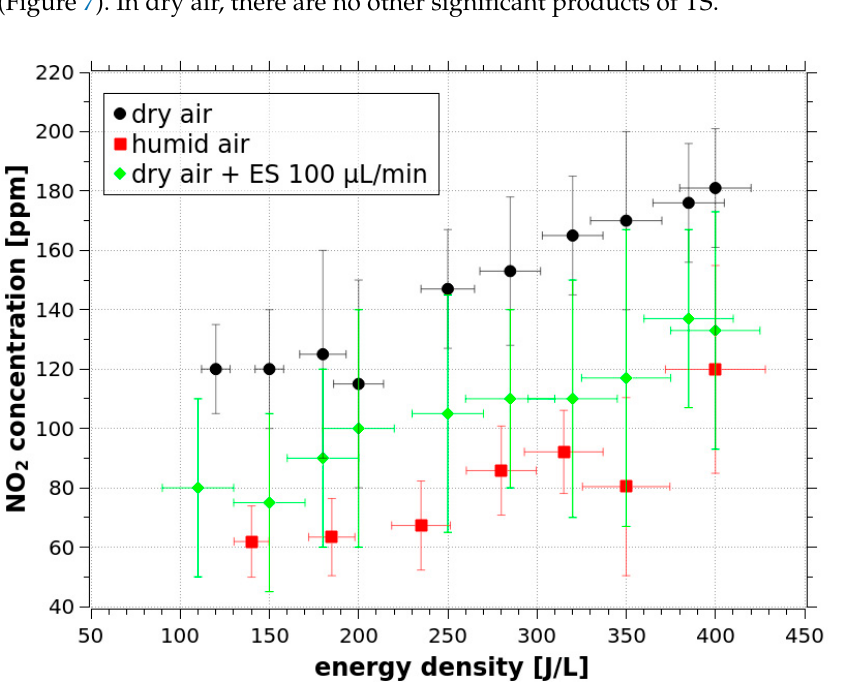
Figure 7. NO 2 concentration as function of the TS input energy density, measured by UV-Vis absorption technique, short absorption cell, 1SS.